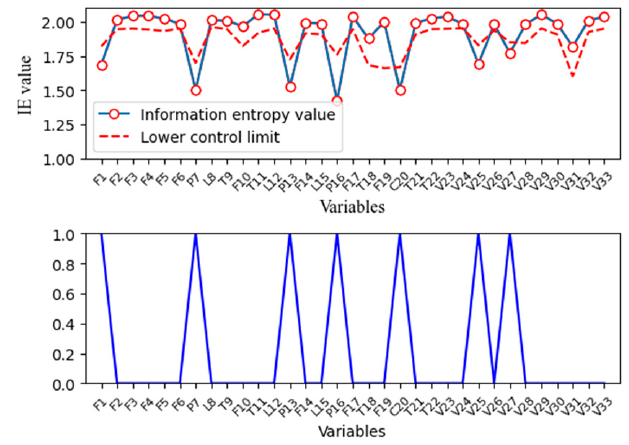
Figure 10. IE value of each variable in fault 1.